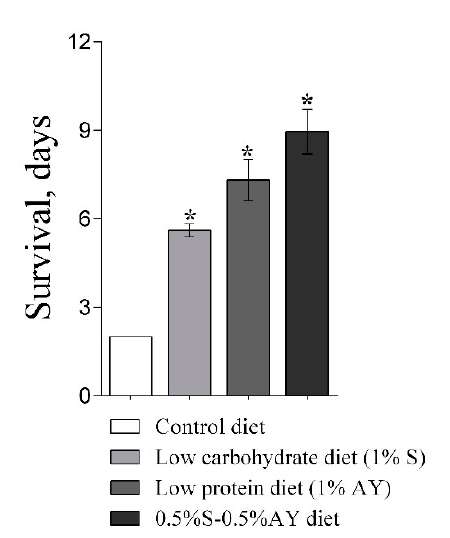
Figure 7. Mean lifespan of flies with inhibition of IIS in ISCs ( esg / InR-RNAi ) under di ff erent dietary regimens. Asterisks show a significant di ff erence from the standard dietary condition (5%S + 5%Y) with p < 0.05.